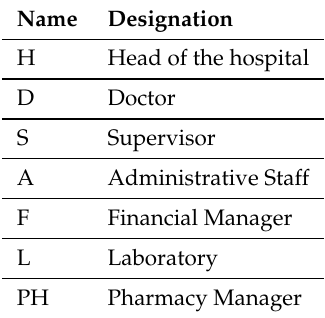
Table 3. Employees’ names in a hospital and their designations.